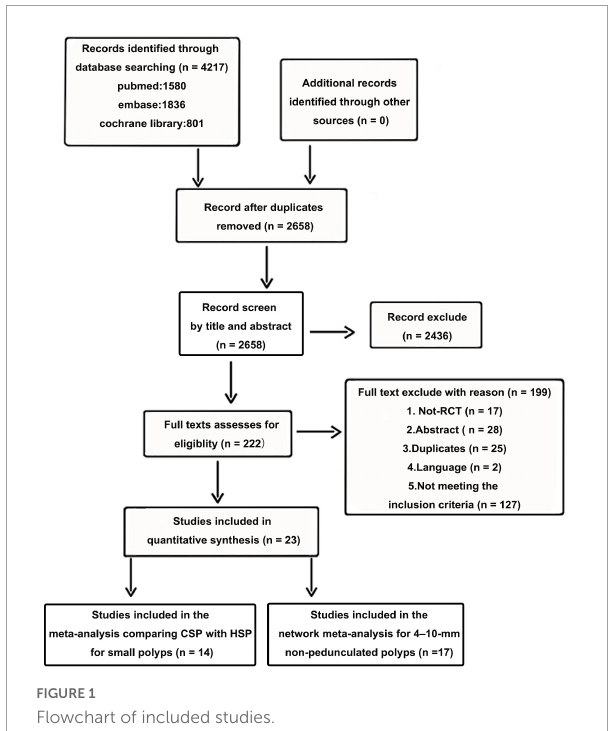
FIGURE1 Flowchart of included